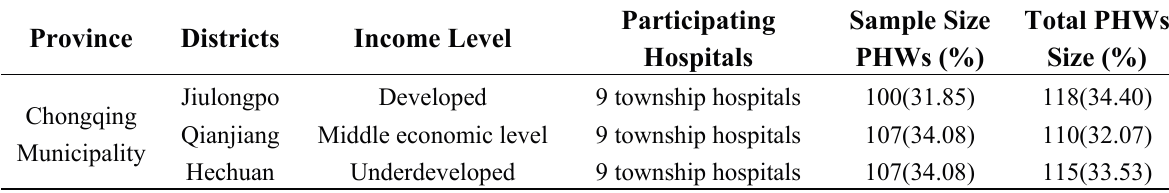
Table 1. Sampling strategy and achieved sample size by